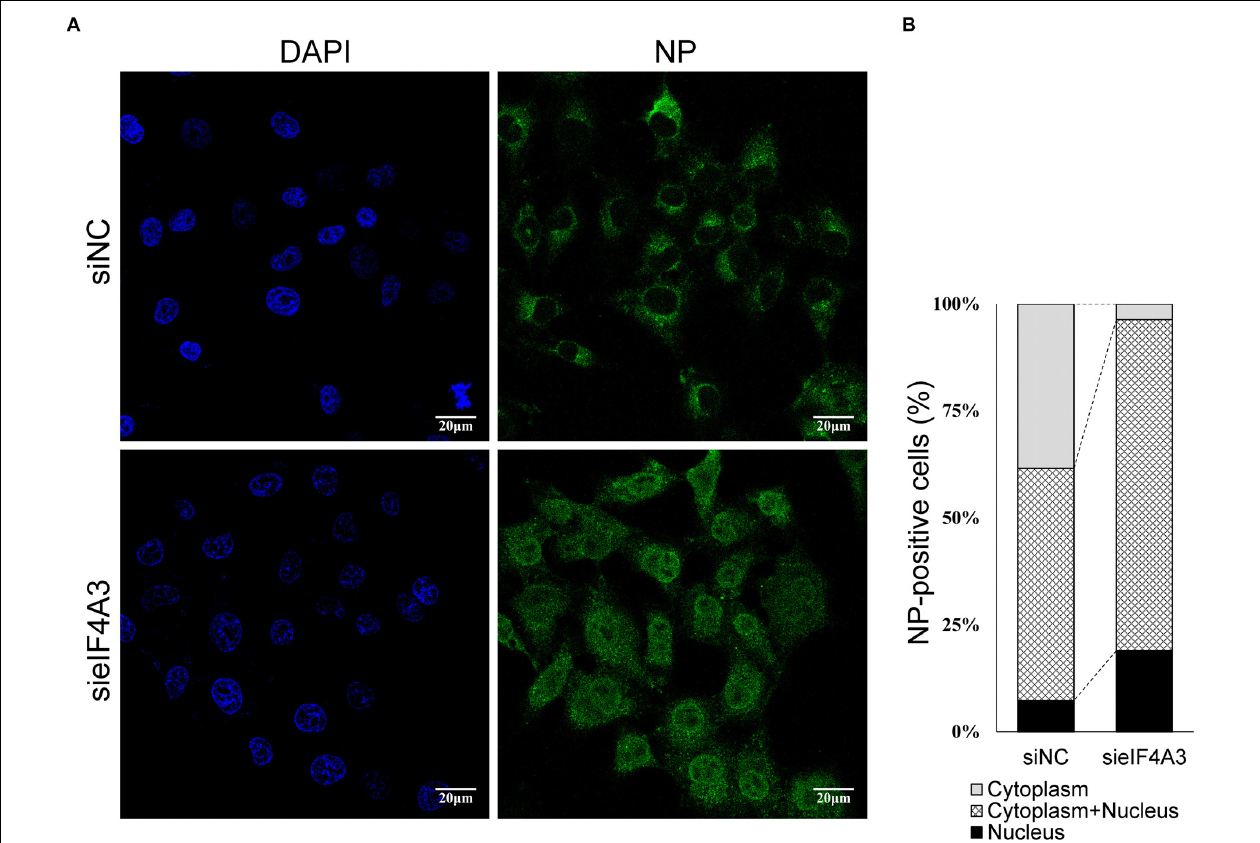
FIGURE 8 | eIF4A4 knockdown accumulates viral NP proteins in the nucleus. (A) A549 cells were transfected with NC or eIF4A3 siRNA for 36 h and infected with influenza virus V at MOI = 5. After 5 hpi, cells were fixed and analyzed by immunofluorescent staining with anti-NP antibody, followed by Alexa Fluor 488 goat anti-mouse antibody. Nuclei were counterstained with DAPI, and the cells were visualized under an Olympus laser scanning confocal fluorescence microscope. (B) Percentage of cells with different NP